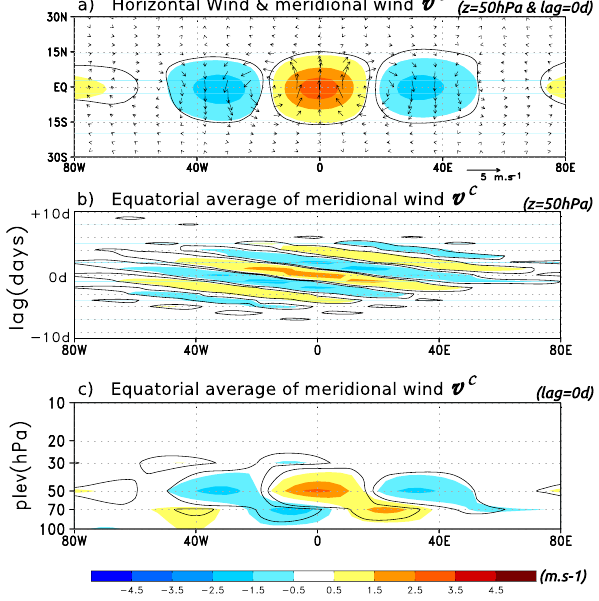
Fig. 8. Same as Fig. 7 for LMDz-E. Fig. 9. Same as Fig. 7 for ERAI selecting dates when the zonal mean zonal wind is negative at 50hPa